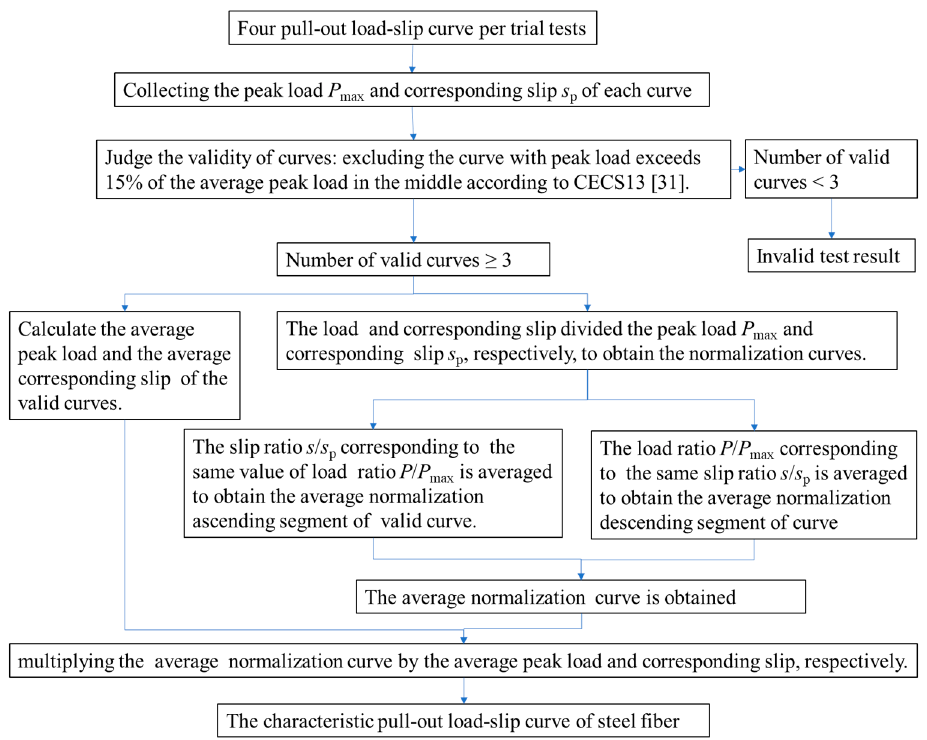
load-slip curve of HF6 is obtained by multiplying the average normalized curve with the average of the peak load and corresponding slip, respectively.